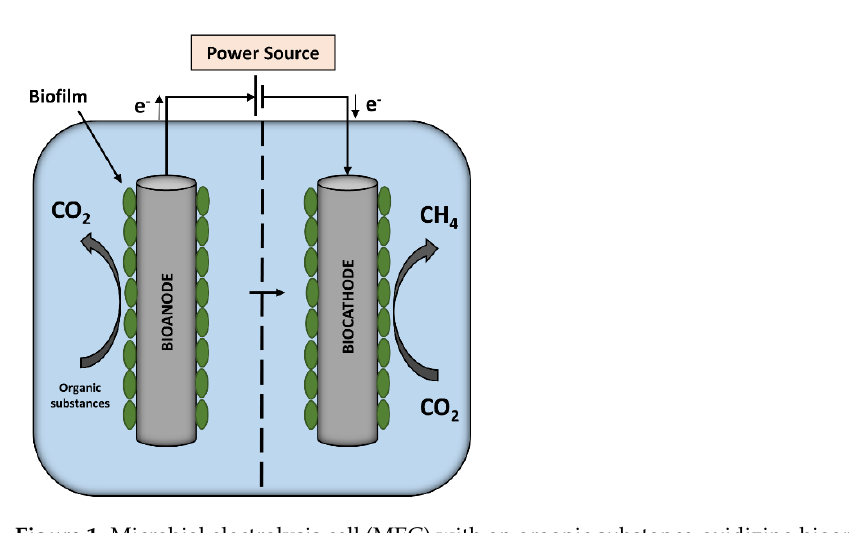
Figure 1. Microbial electrolysis cell (MEC) with an organic substance-oxidizing bioanode combined with a methane-producing biocathode.